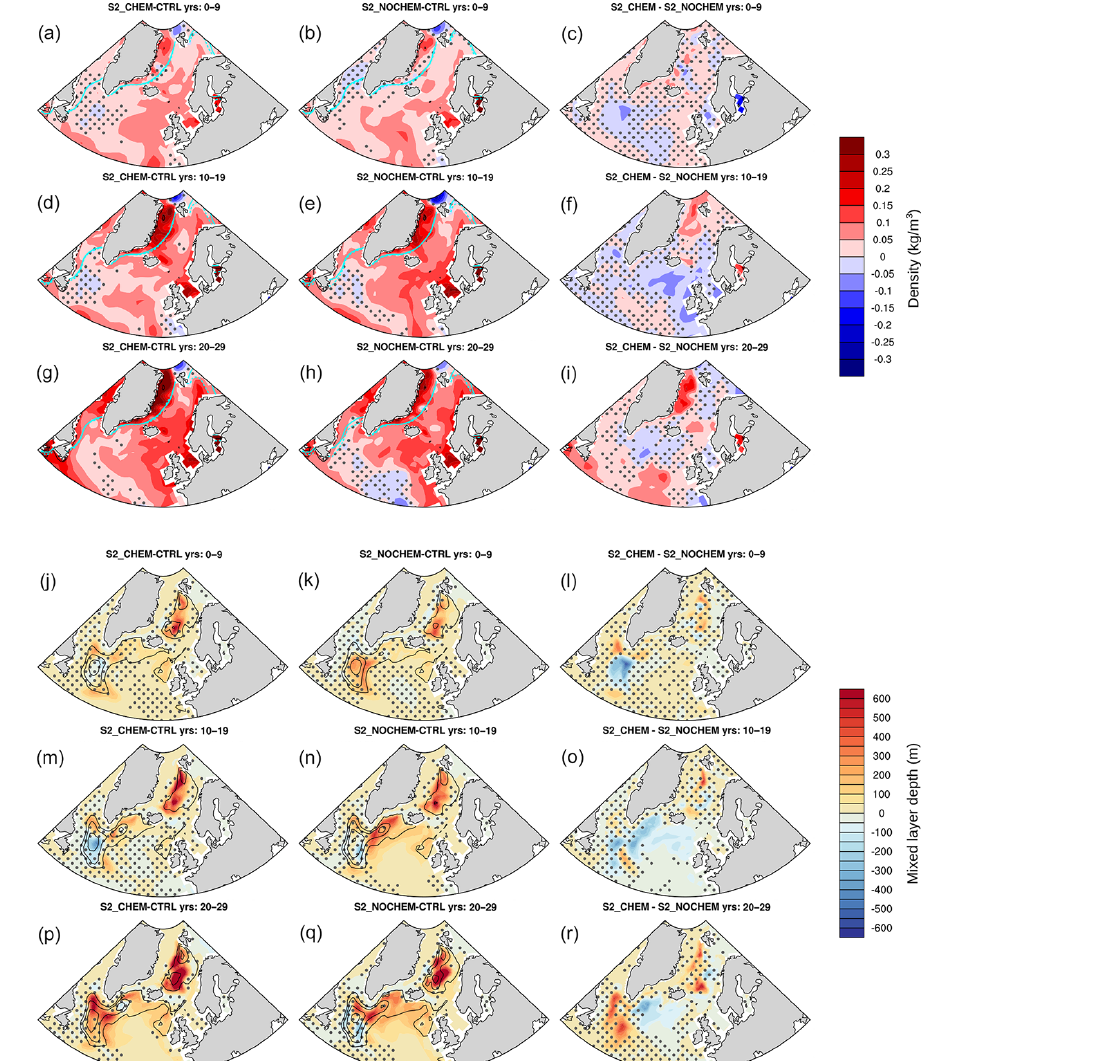
Figure 3. (a–i) S2_CHEM (a, d, g) , S2_NOCHEM (b, e, h) , and the difference between S2_CHEM and S2_NOCHEM (c, f, i) ensemble mean upper ocean (0–220m) density anomalies (kgm − 3 ) for late winter (January–March) averaged over the first (a–c) , second (d–f) , and last decade (g–i) of the SRR period. Cyan contours display the extent of the 50% sea ice area for the CTRL ensemble mean (solid line) and the SRR experiments (dashed line). Panels (j–r) : S2_CHEM (j, m, p) , S2_NOCHEM (k, n, q) , and the difference between S2_CHEM and S2_NOCHEM (l, i, r) ensemble mean January–March mixed layer depth anomalies ( m , shading) averaged over the first (j–l) , second (m–o) , and last decade (p–r) of the SRR period. Contours denote the average January–March mixed layer depth in CTRL_CHEM and CTRL_NOCHEM, with a contour step of 500m. Dots denote non-significant density or mixed layer depth differences (Student’s t test, p >